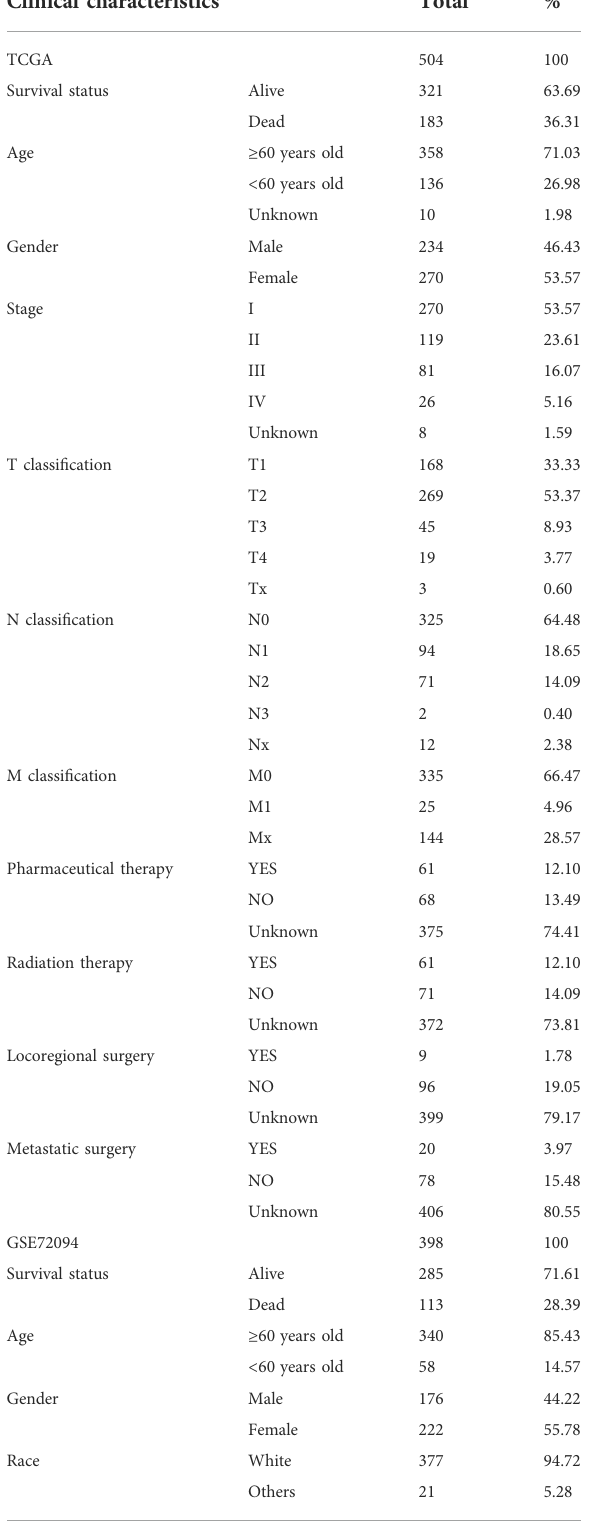
TABLE 2 The clinical characteristics of LUAD patients in the TCGA and GSE72094 datasets. Clinical